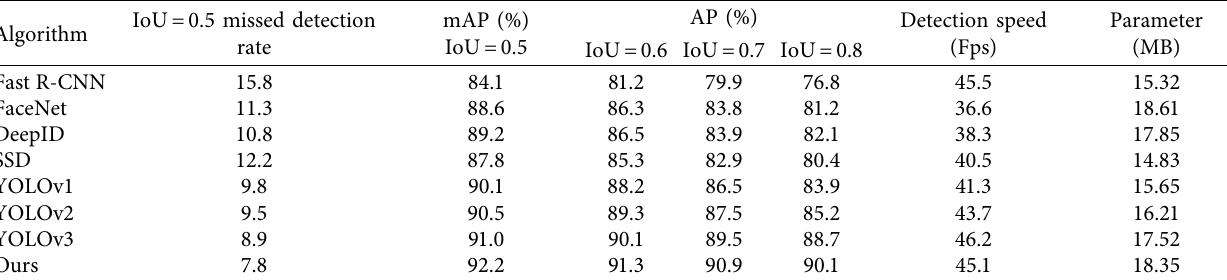
Table 2: Comparison of calculation results of different methods.